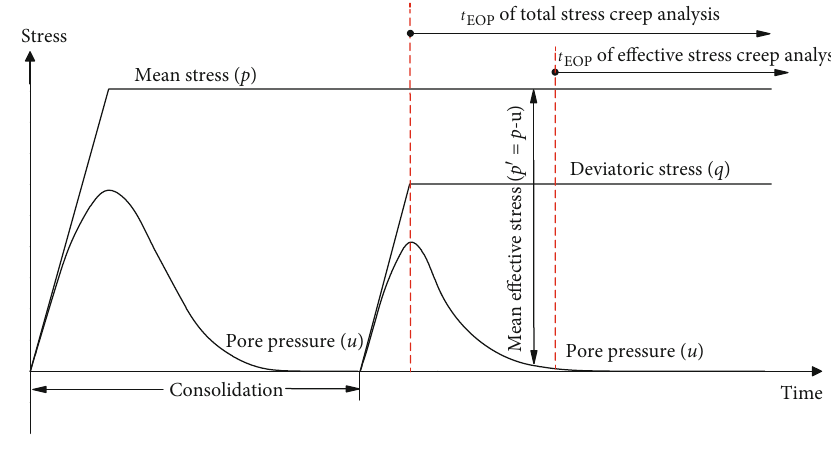
Figure 1: Total stress creep and e ff ective stress creep. Table 1: Physical index of soil samples.